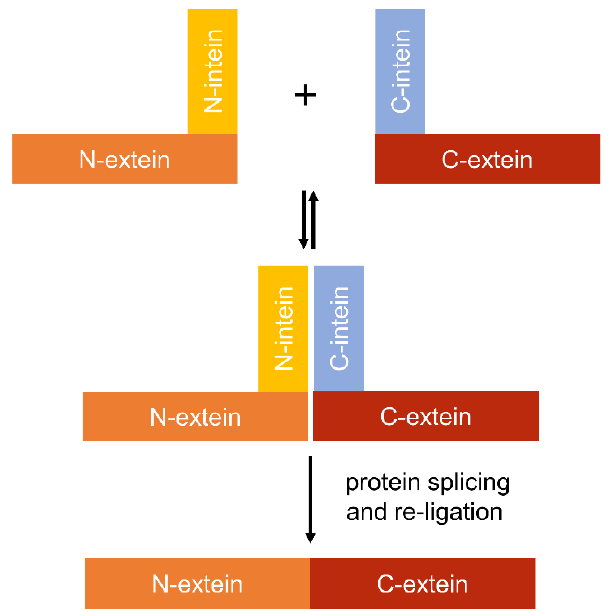
Figure 4. Overview of protein trans-splicing with split inteins. Each precursor protein is composed of a split intein (an N -intein half or a C -intein half) fused to an extein (an N -extein half and a C -extein half). When the split inteins are brought into close proximity, they undergo an autocatalytic trans-splicing reaction. During this process, each split intein fragment is cleaved and the extein halves are spliced together to generate an intact protein via a covalent bond.